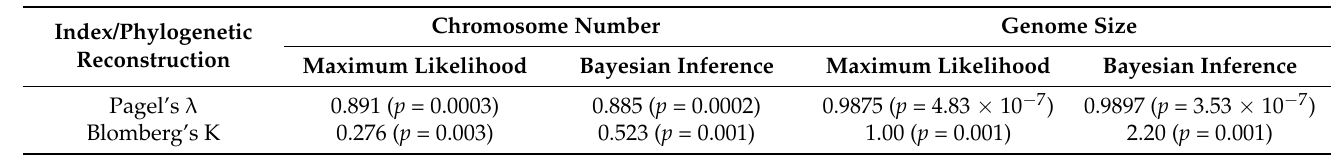
Table 3. Pagel’s lambda and Blomberg’s K phylogenetic signals for chromosome number and genome size under Maximum Likelihood and Bayesian